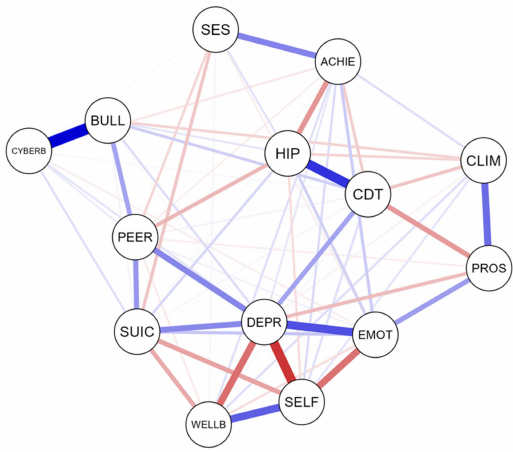
Figure 1. Estimated network of suicidal behaviour, and risk and protective factors. Note: